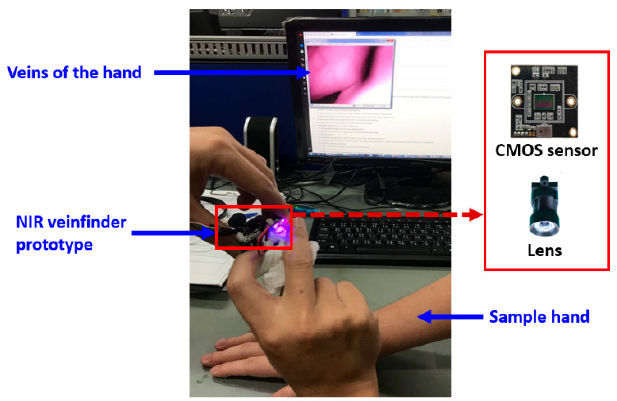
Figure 3. Sample projected vein image of the dorsal hand using NIR vein finder prototype.